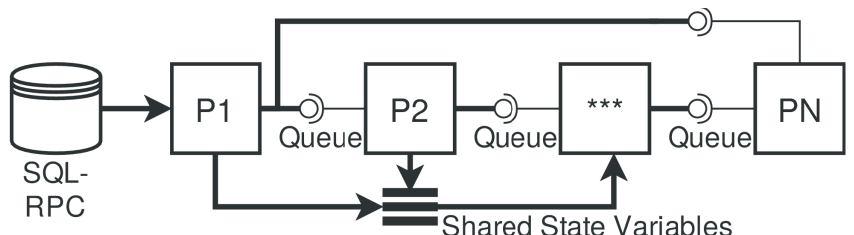
Figure 4. Process pipelines, composed of code snippet processes p i , interconnected by channel queues. Additionally, code snippet processes can exchange data via shared-state variables.